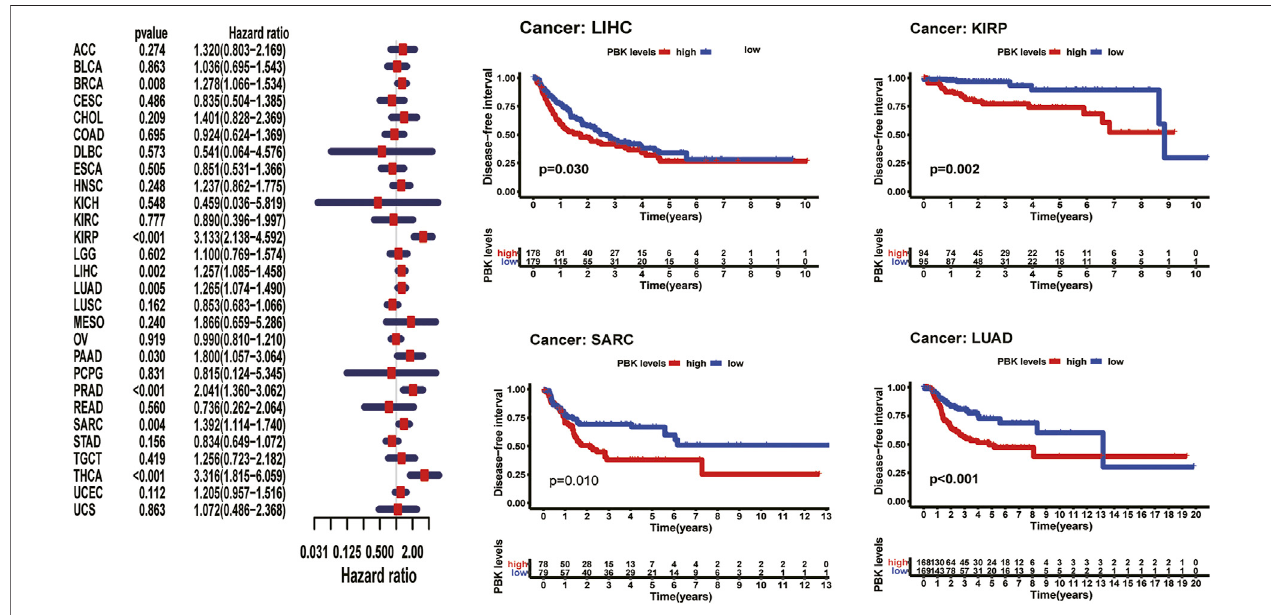
FIGURE 6 | | Relationship between PBK expression and the clinicopathologic stage in 10 tumors.